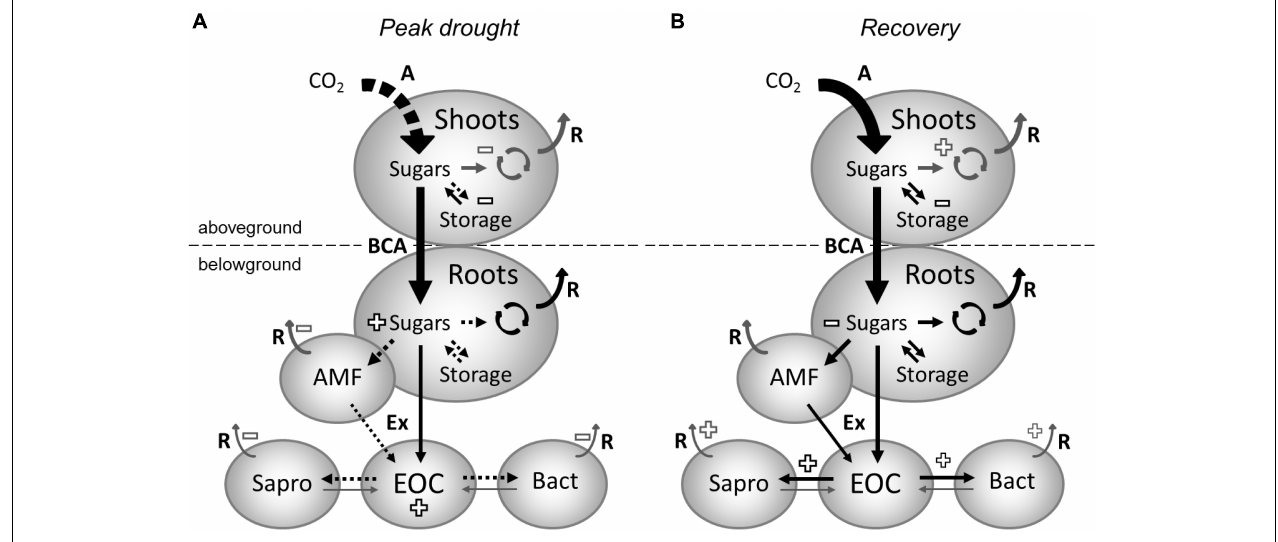
FIGURE 3 | Effects of drought (A) and rewetting (B) on carbon fluxes and pools in grassland ecosystem. (A) During drought, assimilation (A) is reduced (reductions shown as dashed arrows). This leads to reduced carbon allocation to aboveground storage decreasing its pool size (effects on pool sizes shown as “+” or “–” signs). Presumably, carbon allocation to shoot growth, maintenance and respiration (R) is also reduced during drought (fluxes that were not determined in this study are represented by gray arrows). Belowground carbon allocation (BCA) is maintained during drought and leads to the accumulation of root sugars because carbon allocation to storage and mycorrhizal interactions are reduced. The size of the root storage pool is unaffected, as its activity is reduced during drought. Root sugars are partially used for root growth and maintenance. Furthermore, there is ongoing exudation (Ex) of new assimilates by roots but not by AM fungi (AMF), leading to an increase of the extractable organic carbon (EOC) in the soil, as the carbon uptake and metabolic activity of saprotrophic fungi (Sapro) and bacteria (Bact) is strongly reduced during drought. Shortly after rewetting (B) carbon assimilation and allocation mostly recovers. Because reductions still occur in the shoot storage pool, it is likely that priority is given to shoot re-growth. Accumulations of root sugars and EOC observed during drought rapidly vanish after rewetting and are likely used for priming soil microbial activity. In addition, the root sugar pool is reduced due to a faster carbon turnover, which is associated with increased transfer of newly assimilated carbon to saprotrophic fungi and (by tendency) bacteria in the rhizosphere, indirectly suggesting increased root/mycorrhizal exudation.